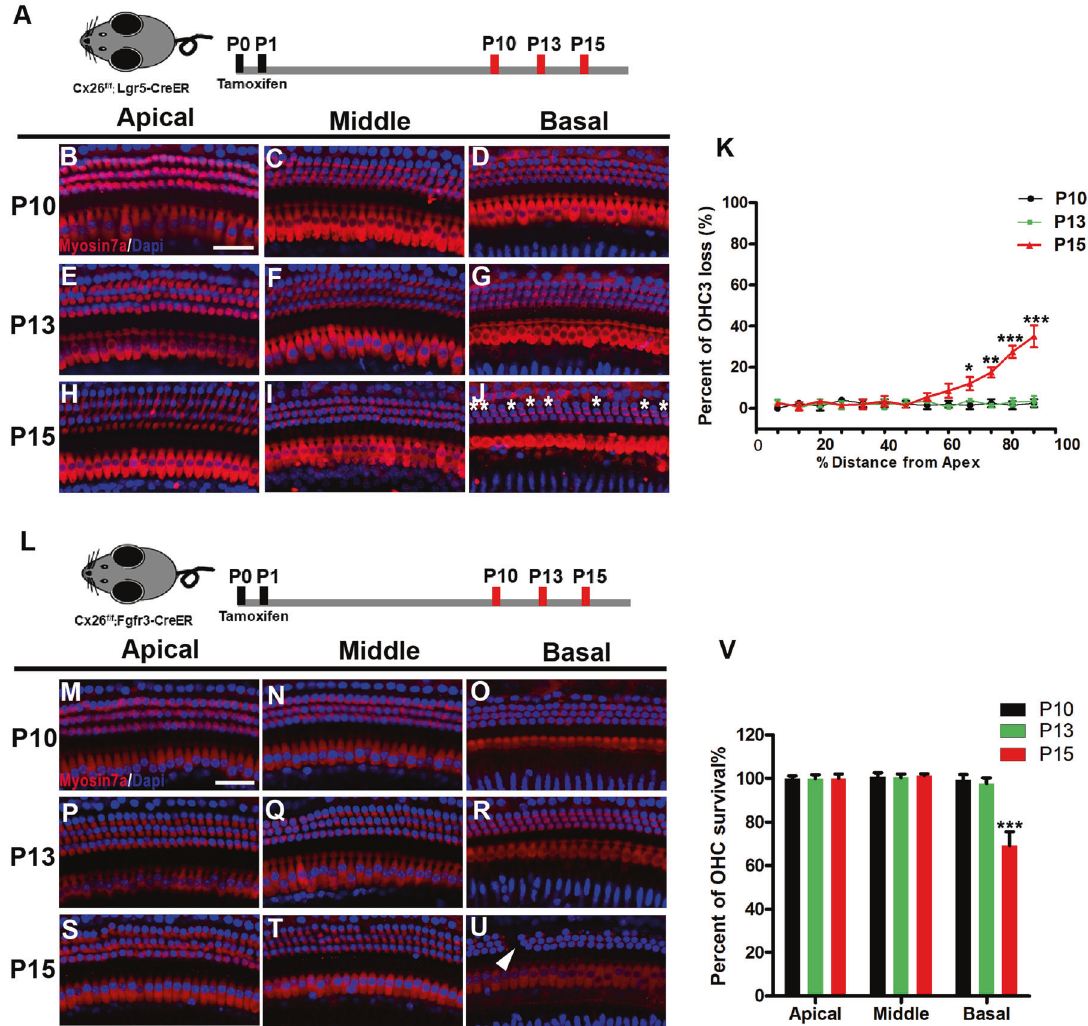
Fig. 2 Degeneration pattern of hair cell in Cx26-null mice at different postnatal time points. A Schematic of the experimental work fl ow, Cx26 f/f ; Lgr5-CreER mice were sacri fi ced at P10, P13, or P15 for examination. B – J Immuno fl uorescence staining with myosin 7a (red) and DAPI (blue) in different turns of the Cx26 f/f ; Lgr5CreER mice at different time points, white asterisks indicate the missing OHC3. K Quanti fi cations of OHC3 loss at the different time points. L Cx26 f/f ; Fgfr3-CreER mice were sacri fi ced at P10, P13, or P15 for examination. M – U Immuno fl uorescence staining with myosin 7a (red) and DAPI (blue) in different turns of the Cx26 f/f ; Fgfr3-CreER mice at different time points, white arrows indicate the missing OHCs in the basal turns of Cx26 f/f ; Fgfr3-CreER mice at P15. V Quanti fi cations of OHCs loss at speci fi c cochlear locations at the different time points. * P < 0.05, ** P < 0.01, *** P < 0.001. Scale in panels ( B and M ) represents for 40 μ